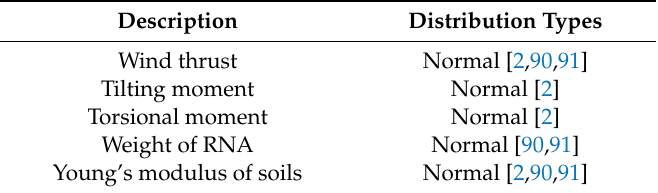
Table 8. Stochastic